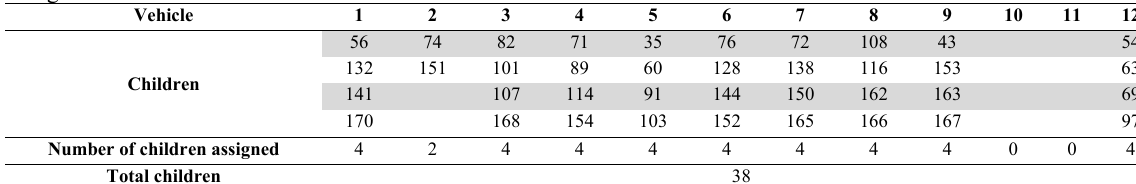
Assignment of children to vehicles with the mathematical model